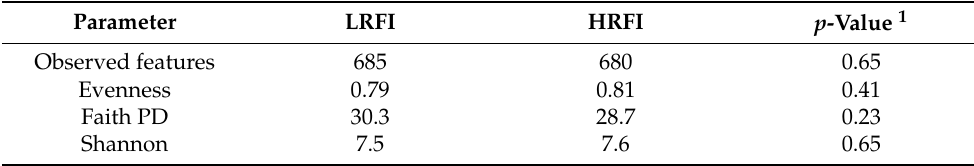
Table 4. Mean alpha diversity parameters from method A using the filtered